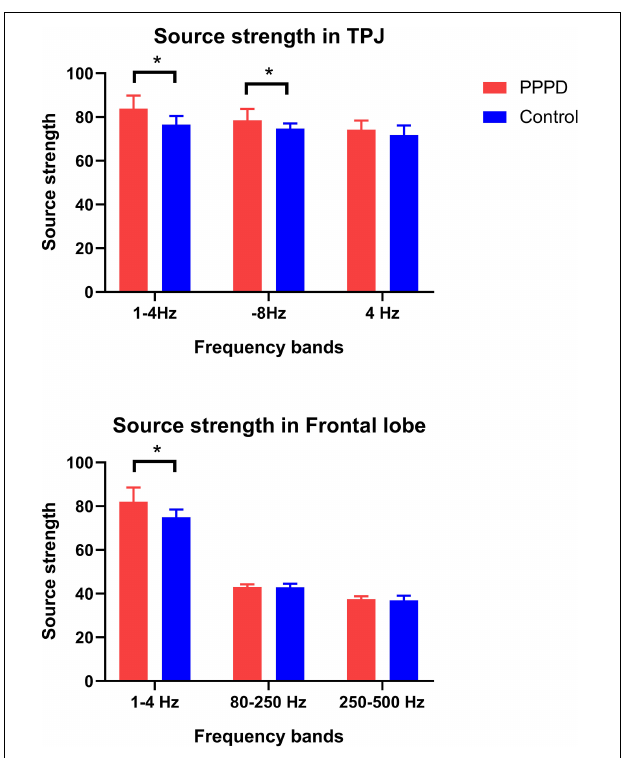
TABLE 2 | Comparison of neuromagnetic source strength between PPPD patients and controls. Frequency bands PPPD patient Control P value